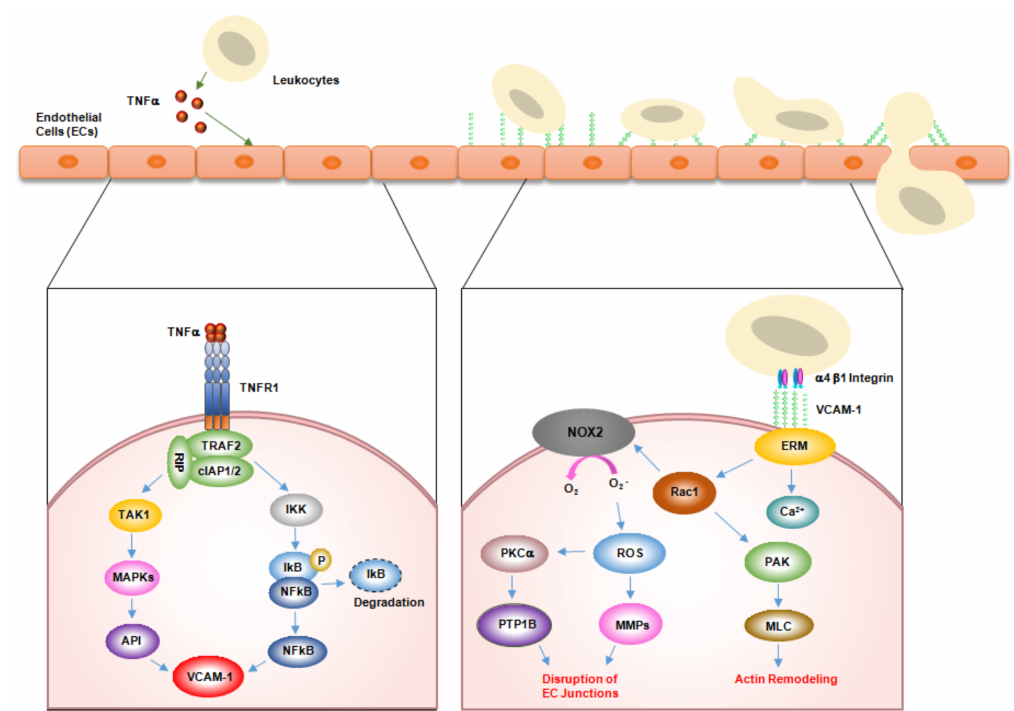
Figure 1. Mechanism of vascular cell adhesion molecule-1 (VCAM-1)–mediated leukocyte adhesion and transendothelial migration across endothelial cells. In inflammation, tumor necrosis factor alpha (TNF α , which is mainly secreted from leukocytes, upregulates VCAM-1 expression on the surface of endothelial cells. VCAM-1 on activated endothelial cells directly interacts with α 4 β 1 integrin on leukocytes. In turn, this interaction activates VCAM-1 downstream signaling molecules, including Ca 2+ , Rac1, nicotinamide adenine dinucleotide phosphate oxidase 2 (NOX2), reactive oxygen species (ROS), metalloproteinases (MMPs), protein kinase Ca (PKC α ), and protein tyrosine phosphatase 1B (PTP1B). Eventually, these signals relax the affinity of junction adhesion molecules within endothelial cell inunctions, allowing leukocytes to migrate through the